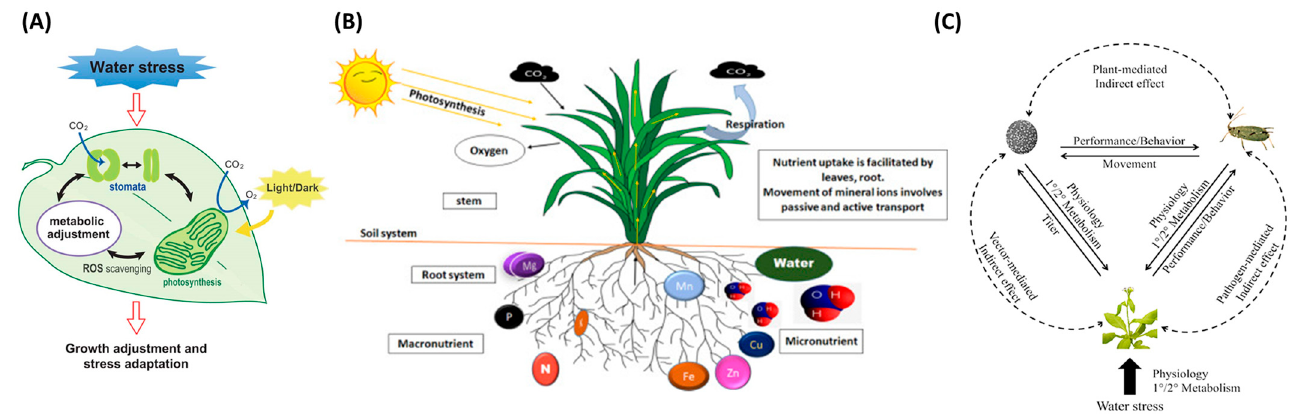
Figure 1. Common stress mechanism in plants. ( A ) water stress (Section 2.1.1), ( B ) nutrient deficiency (Section 2.1.2), and ( C ) pest stress (Section 2.1.3). Reprinted with permission from [15–17].